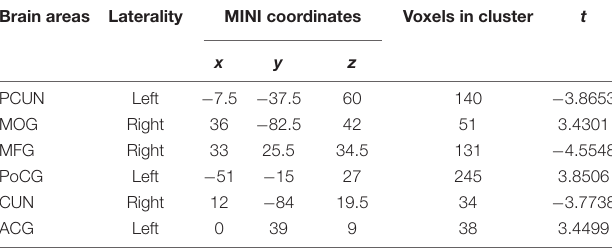
TABLE 3 | Correlation between whole-brain GMV and PDSS scores in PD patients.